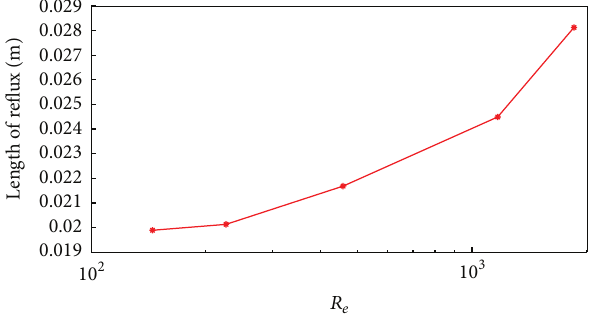
Figure 8: The curve of cross-sectional velocity distribution at the midpoint of output pipe AB.